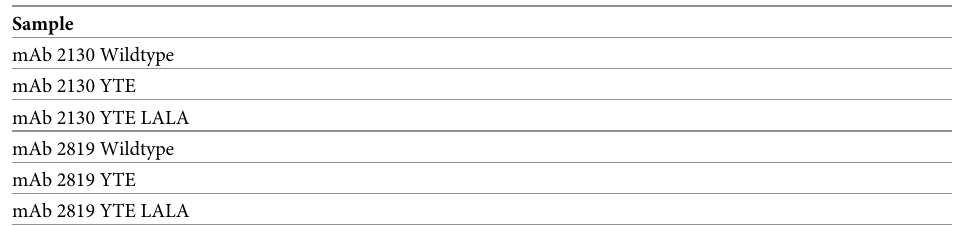
Table 1. List of monoclonal antibodies